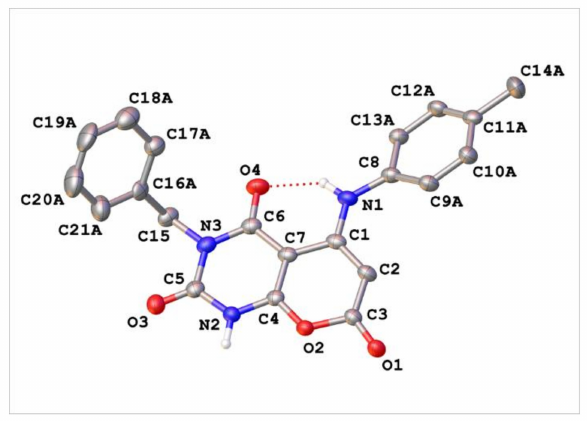
Figure A4. Crystal structure of compound 9c .